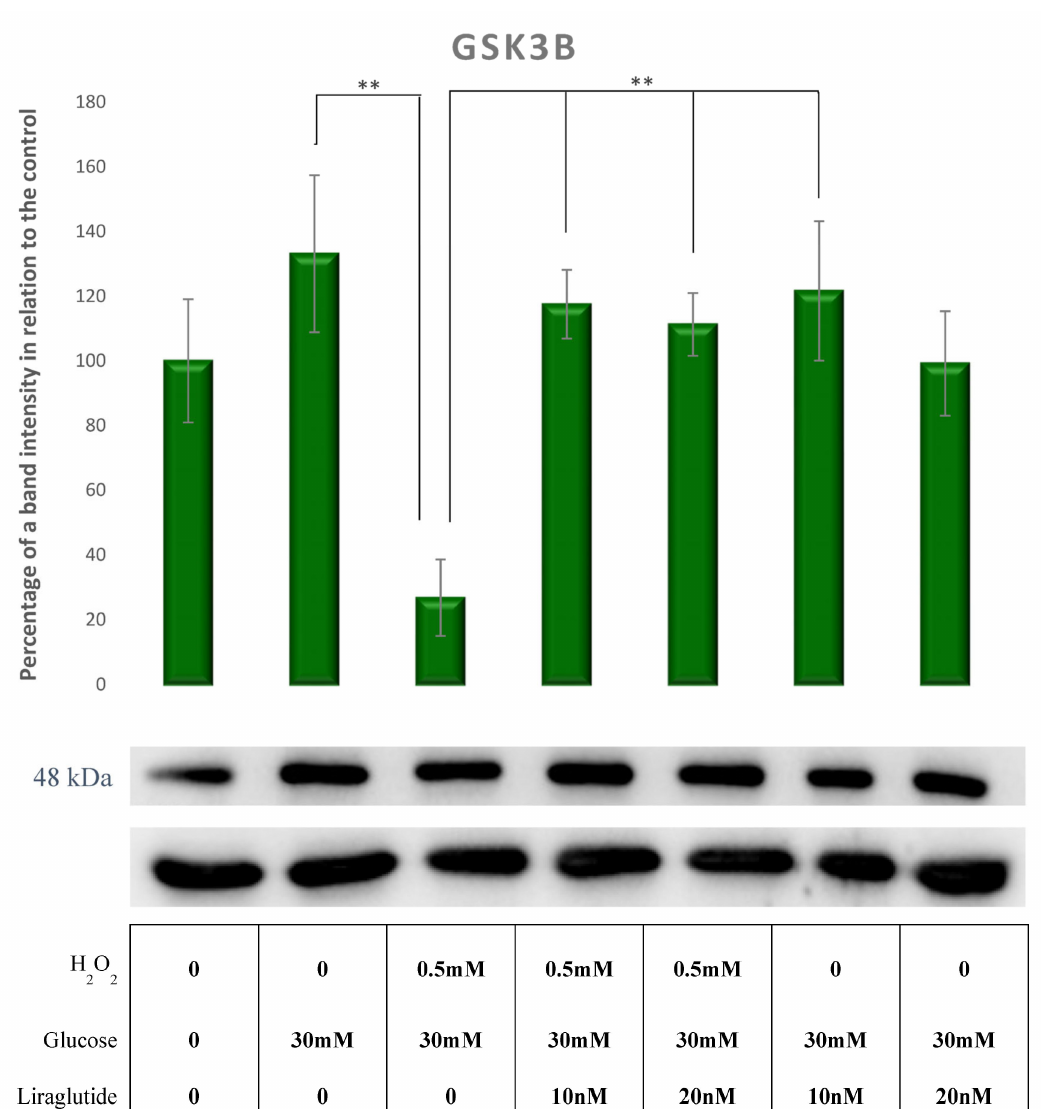
Figure 8. Protein expression in the LLC-PK1-treated cell line (control vs. HG30 and HG30/H 2 O 2 ; HG30 vs. HG30/Lira10 and HG30/Lira 20; HG30/H 2 O 2 vs. HG30/H 2 O 2 /Lira10 and HG30/H 2 O 2 /Lira 20) determined by Western blot. Glyceraldehyde 3-phosphate dehydrogenase (GAPDH) was used as an internal control. The data are shown as the means ± SD (standard deviation) from three independent biological replicates. One-way ANOVA F(6,20) = 4.23, p = 1.23 × 10 − 2 with Tukey HSD post hoc test; ** p < 0.01; Values underneath the x axis represent the amount of compound added in the experiment, and 0 represents that the compound was not added. Protein expression, pig proximal tubule cell line (LLC-PK1), HG (1.5 mM, 30 mM), H 2 O 2 (0.5 mM), Liraglutide (10 nM, 20